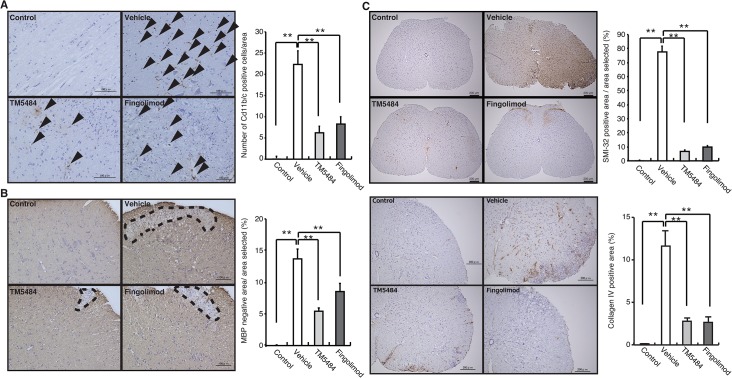
Histological analysis.Representative photomicrographs of control, vehicle, TM5484 (5 mg/kg/d) and fingolimod (0.5 mg/kg/d) sections at dpi. 28. Spinal cord was sectioned and stained with Cd11b (A), MBP (B), SMI-32 (C) and Collagen IV (D). Four sections of the spinal cord (lumbar spinal segments) from each group were examined. Data are expressed as the mean and corresponding SEM. TM5484 significantly reduced macrophage infiltration/microglia activation, demyelination, axonal degeneration as well as deposition of collagen IV in the spinal cord.